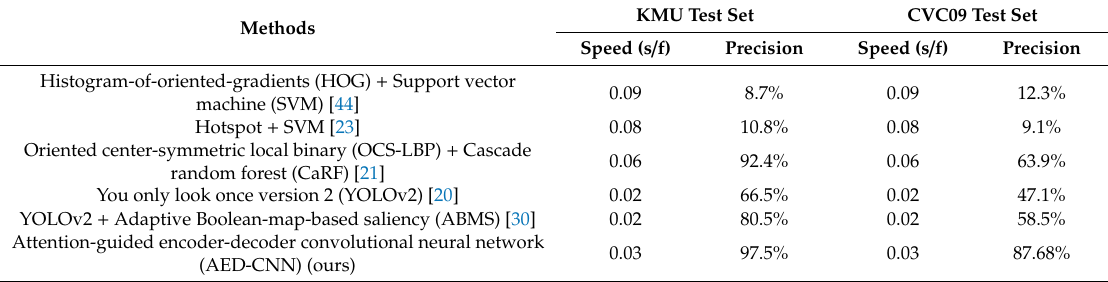
Table 1. Comparison of the computation times and average precisions (APs) for the Keimyung University (KMU) and Computer Vision Center (CVC)09 test sets.